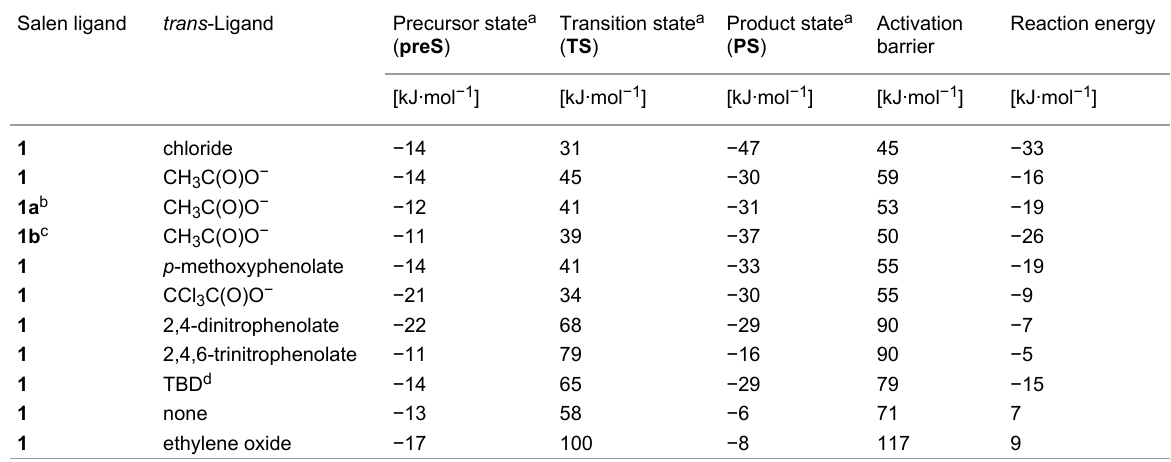
Table 1: Relative energies with respect to free CO 2 and free cobalt(III)–salen complex of the precursor, transition and product state of the CO 2 inser- tion reaction as shown in Figure 4.